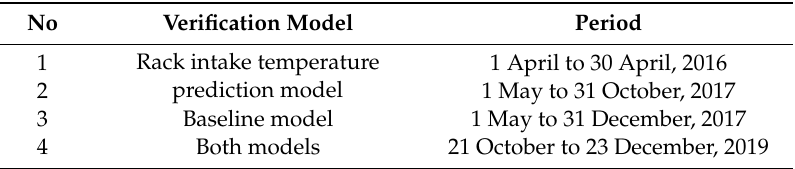
Table 2. Data-set periods used with each